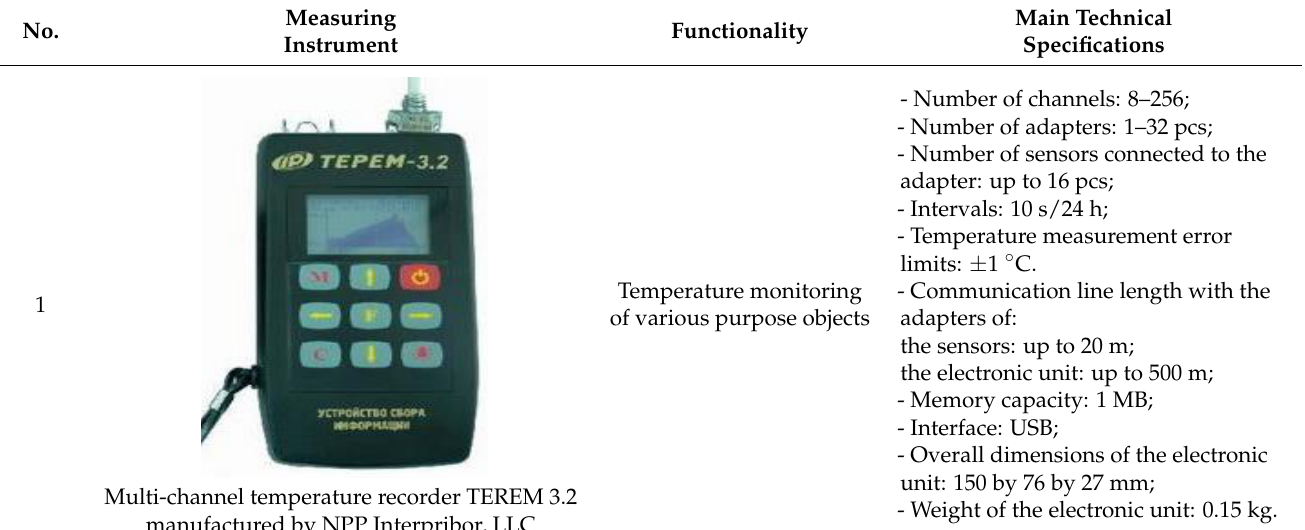
Table 2. Measuring instruments description.